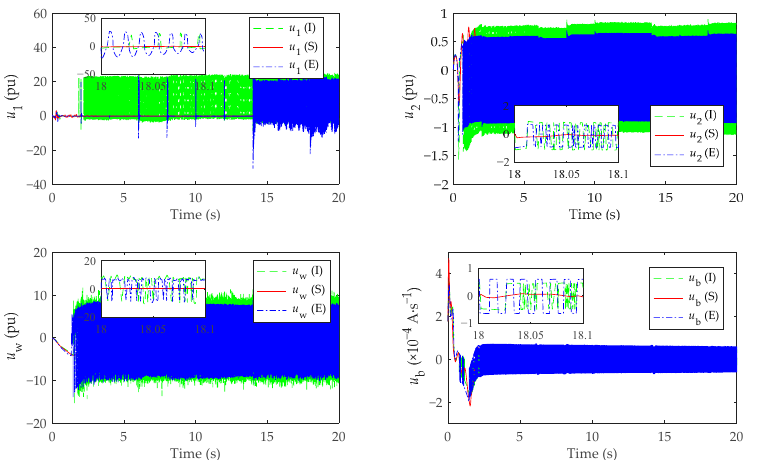
Figure 8. Control signals under different reaching laws.